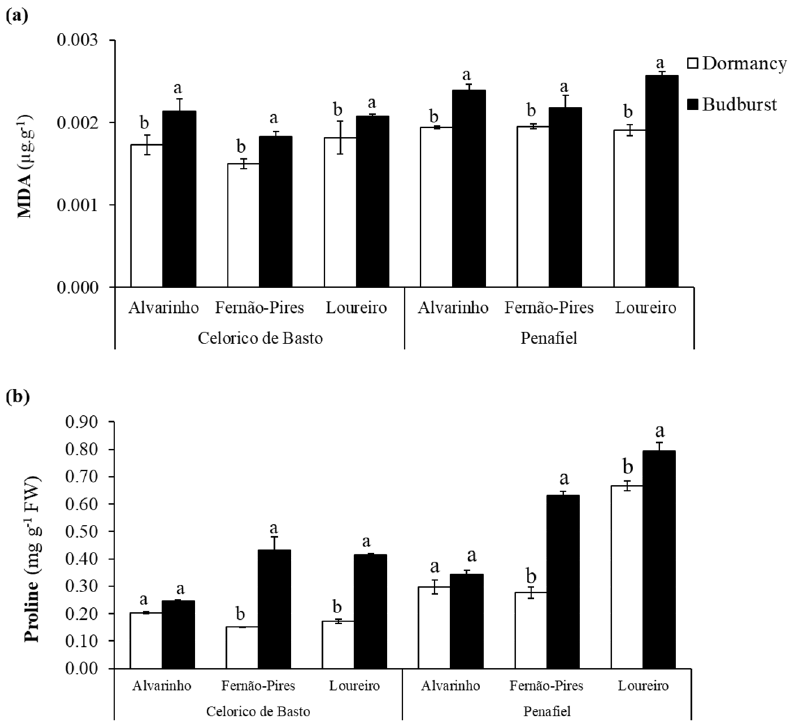
Figure 2. Malondialdehyde (MDA) content ( a ) and proline content ( b ) at dormancy and budburst for Alvarinho, Fernão-Pires, and Loureiro buds from Celorico de Basto and Penafiel vineyards. The columns represent the mean values and the bars the respective standard error of three replicates. Different letters indicate significant differences between phenological stages ( p < 0.05).